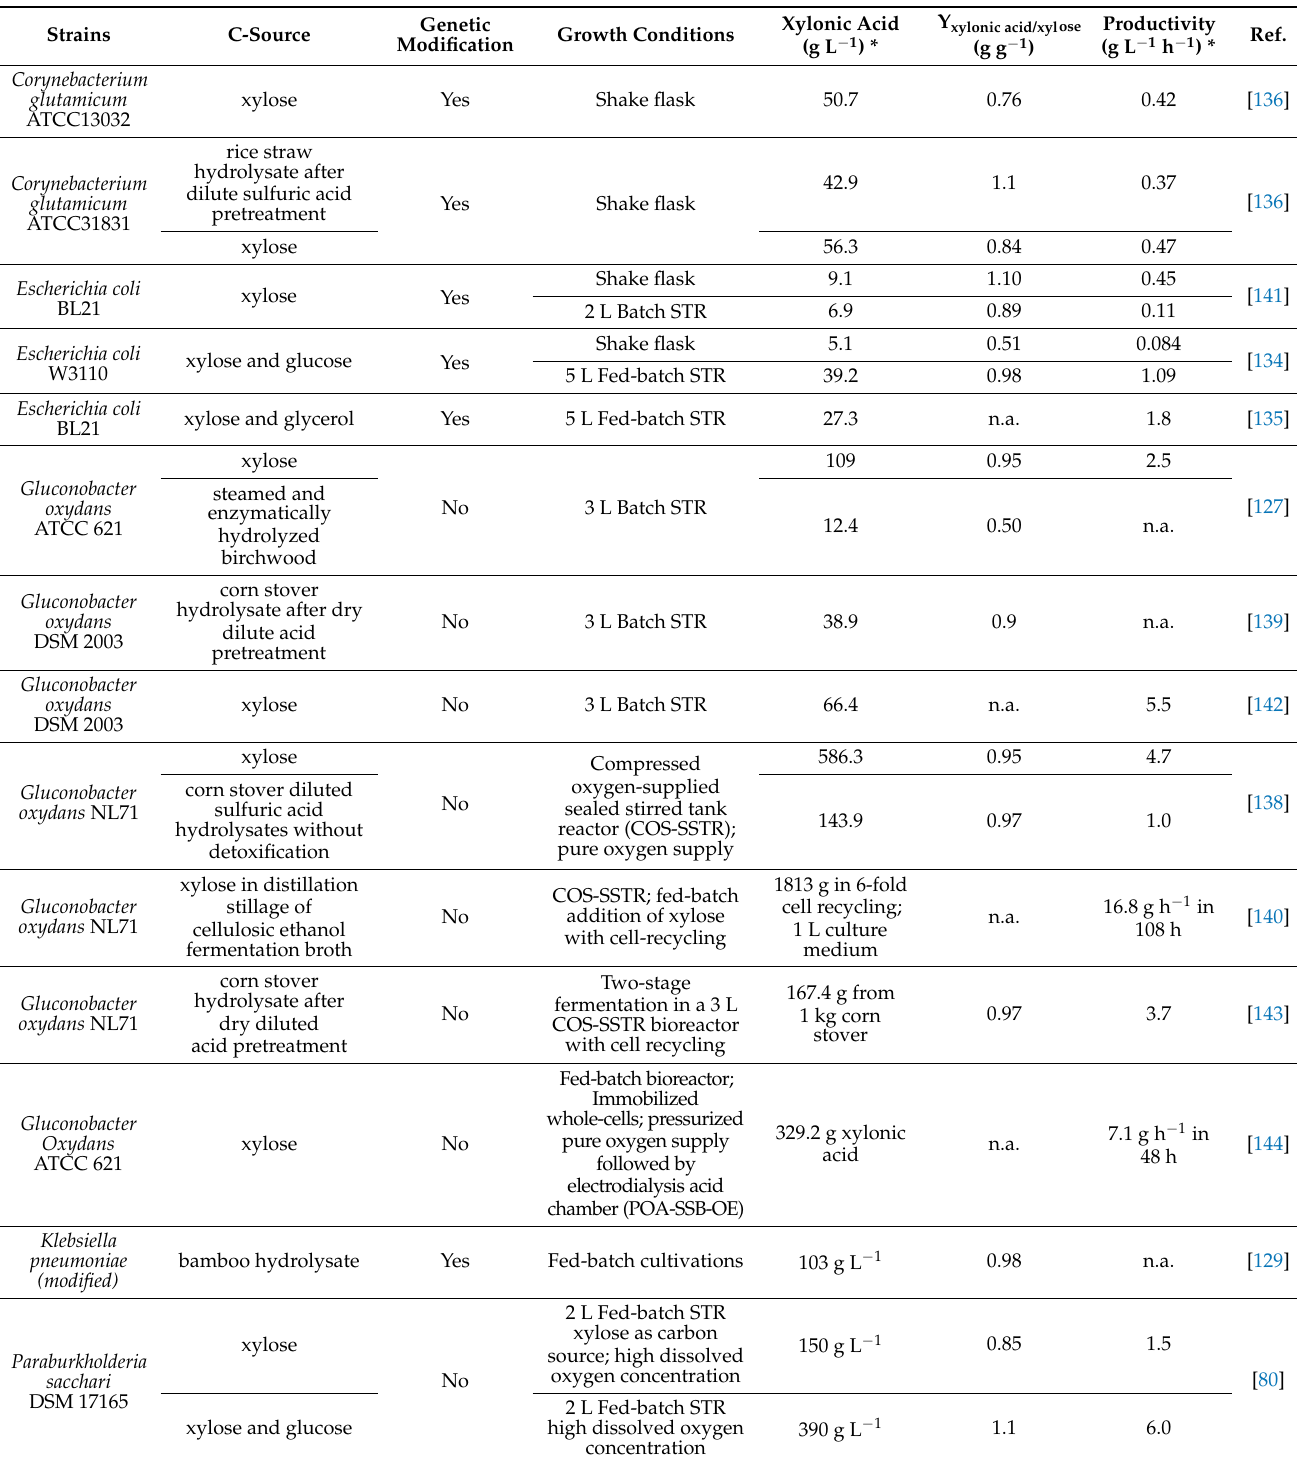
Table 2. List of bacteria (wild type and genetically modified) with potential for D-xylonic acid production from lignocellu- losic biomass (n.a.—information not